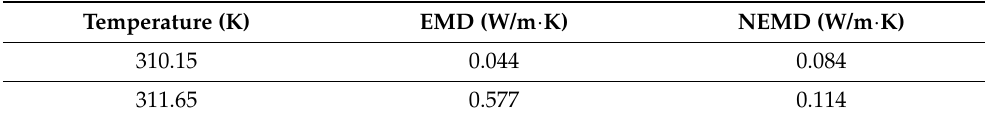
Table 1. Thermal conductivity of FB at normal and fever temperatures. Temperature